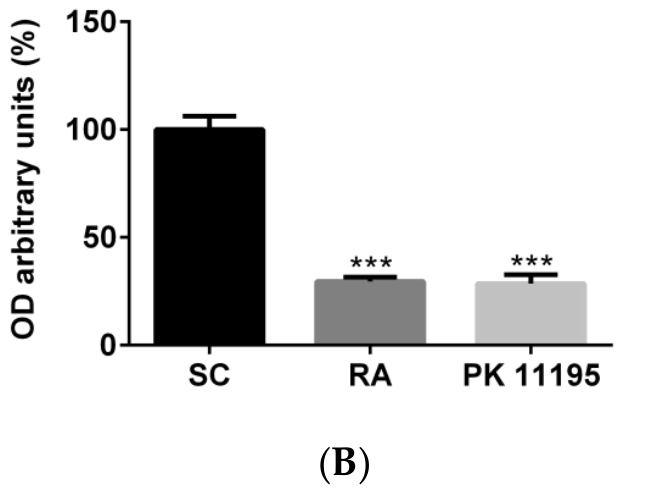
Figure 1. ( A ) Representative immunoblot of the TSPO protein levels in undifferentiated P19 stem cells (SC) and cells treated with 1 µ M retinoid acid (RA) or 50 µ M PK 11195 (PK 11195) during 4 days of treatment. ( B ). Bar chart shows quantification of the optical densities (OD) from three independent cell cultures and treatments. Data are expressed as means ± SEM. *** p < 0.001 versus SC.